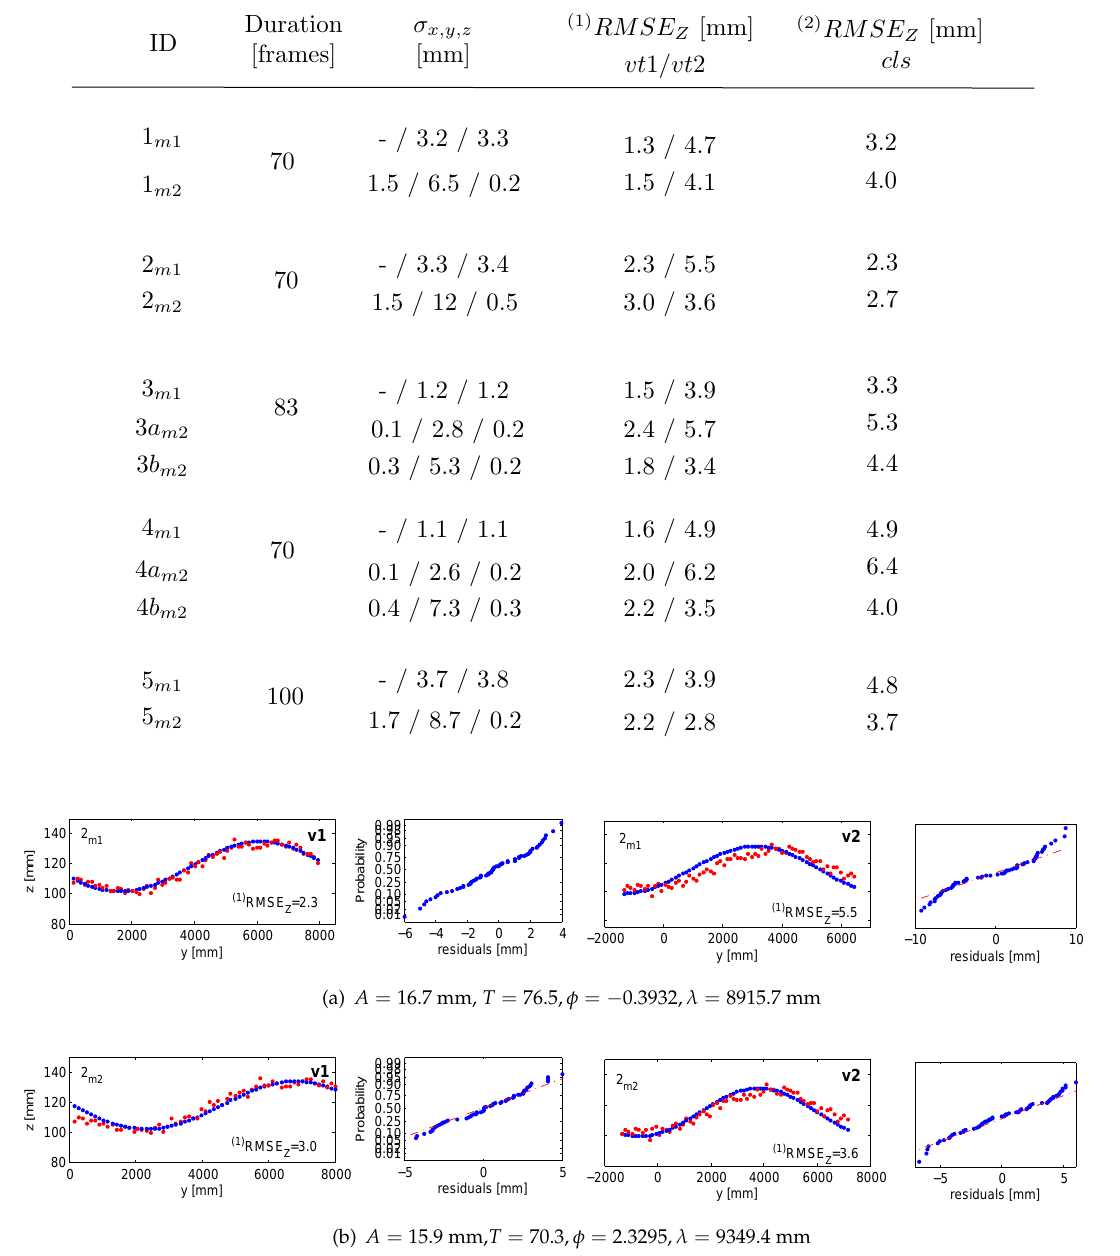
Figure 14. Accuracy 1 validation results in the second measurement series for m 1 in ( a ) and m 2 in ( b ), compared against the response of vt 1 and vt 2. Ground truth in red; fitted wave model in blue. The normal probability plots are in even